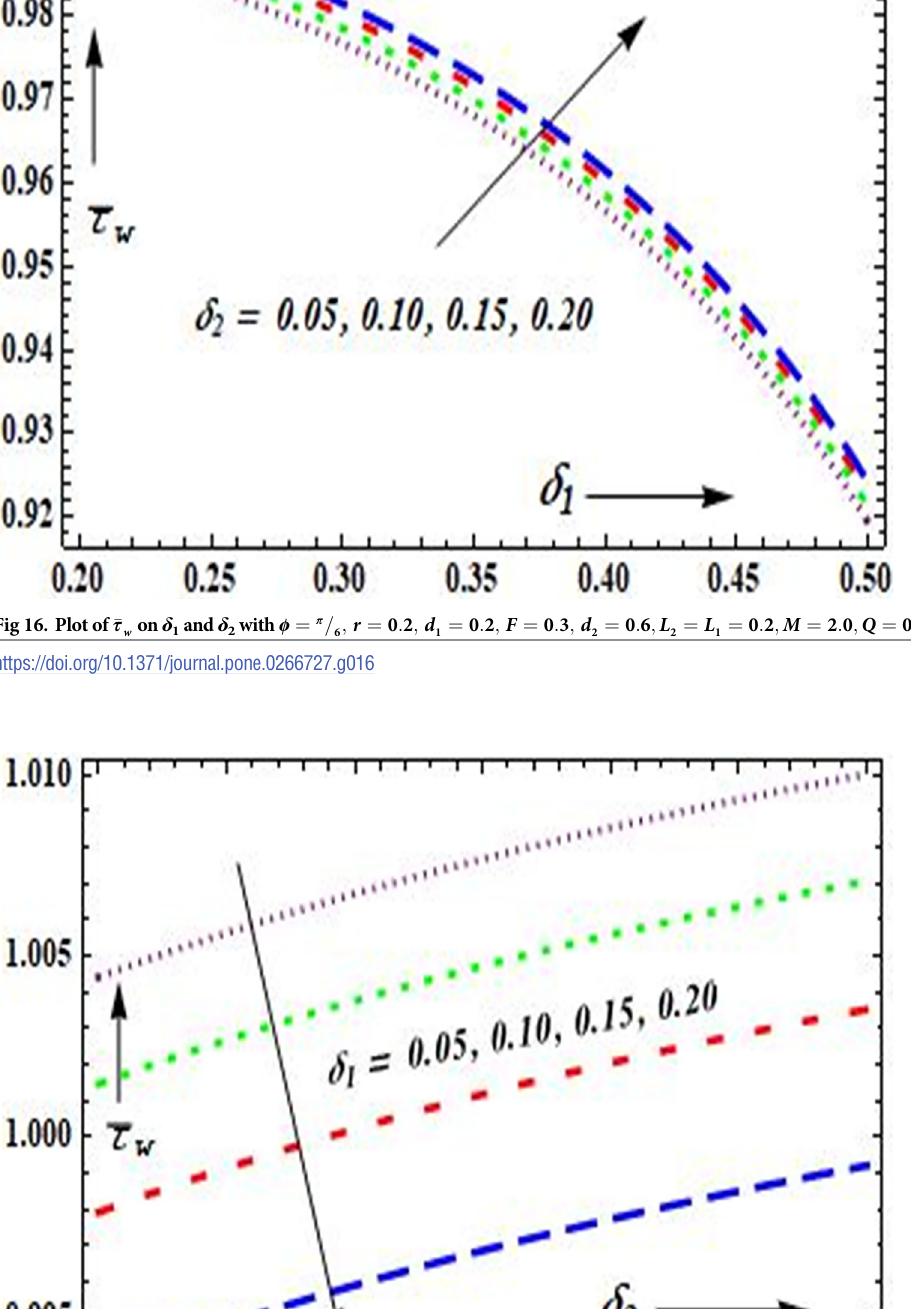
on δ 2 and δ 1 with ϕ ¼ π w